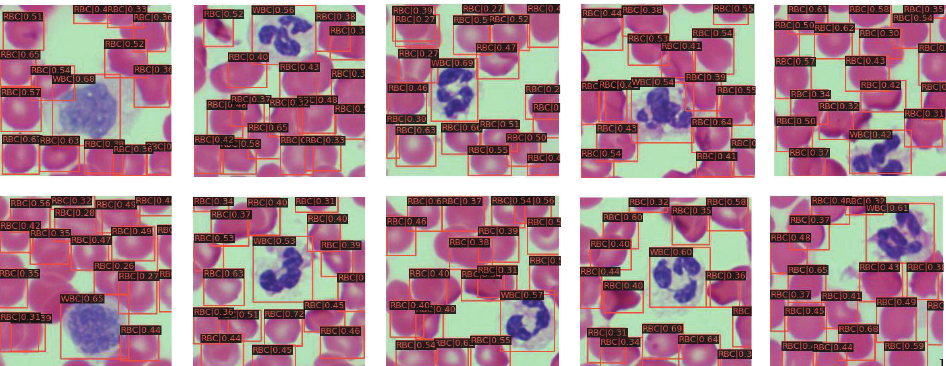
Figure 4. Visualization detection results on BCDD dataset.